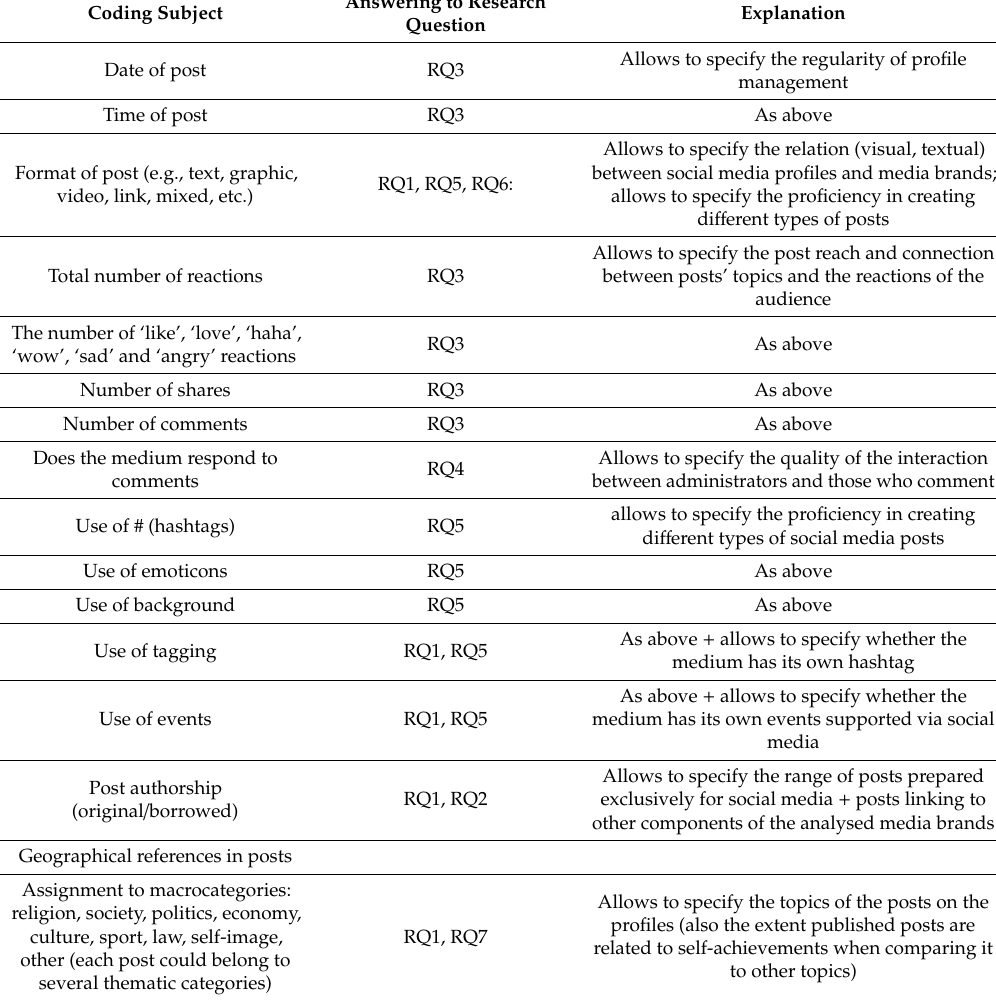
Table 1. Content coding schedule for Facebook (FB) profile—Stage